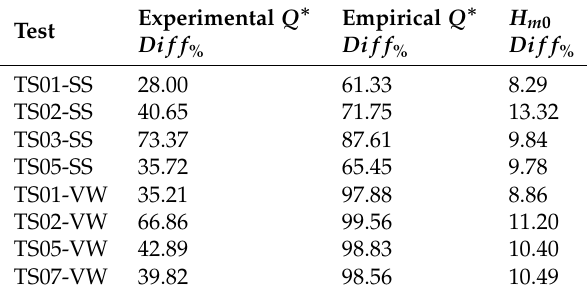
Table 3. Percentage difference in H m 0 and Q ∗ for random seeding